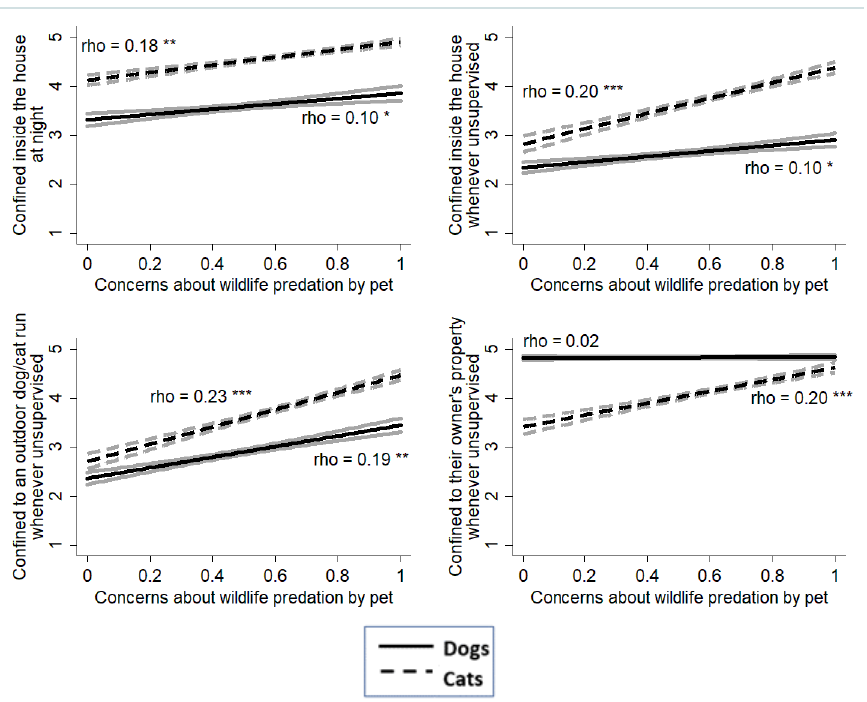
Figure A2. Bivariate associations between concerns about wildlife predation and individual items on pet confinement, separately for dogs (in 1291 dog owners) and cats (in 1146 cat owners); Spearman’s correlation coefficients (rho) are presented for each line with significance level denoted by the asterisk (* p < 0.05, ** p < 0.01, *** p > 0.001).